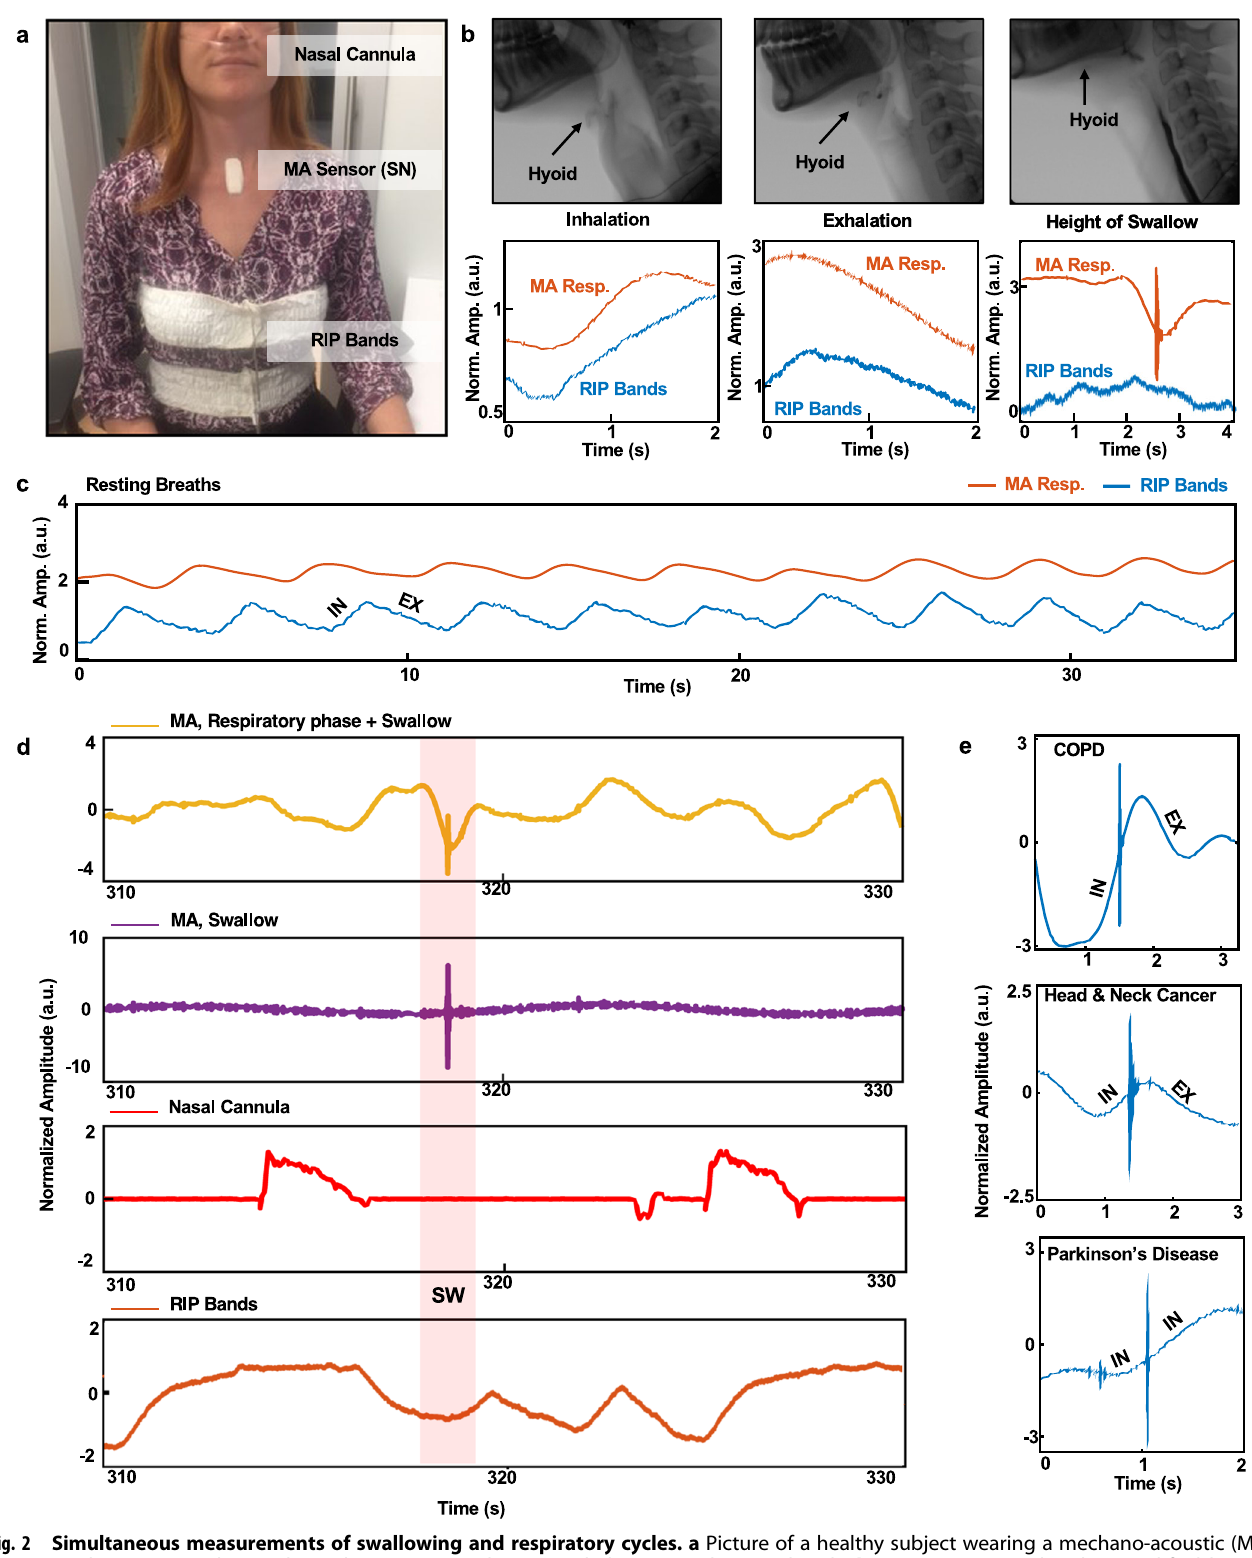
Fig. 2 Simultaneous measurements of swallowing and respiratory cycles. a Picture of a healthy subject wearing a mechano-acoustic (MA) device at the SN, a nasal cannula, and respiratory inductance plethysmography (RIP) bands. b Images associated with a modi fi ed barium swallow study (MBSS) of a patient suffering from dysphagia and corresponding MA measurements. c Respiratory phase during rest breaths performed by a healthy subject. d Sample swallow event from a healthy subject with synchronized combined MA respiratory phase and swallow signal (yellow), fi ltered MA swallow signal (purple), nasal air fl ow signal (red), and calculated RIP signal (orange). e Various swallows from chronic obstructive pulmonary disease (COPD), head and neck cancer, and Parkinson ’ s disease patients, highlighting the importance of swallow training for patients suffering from